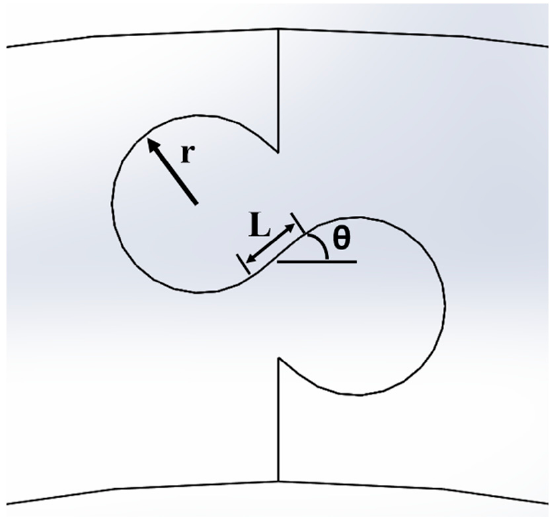
Figure 2. Three suture geometry parameters were varied: tab radius (r), contact angle ( θ ), and tangent length (L).